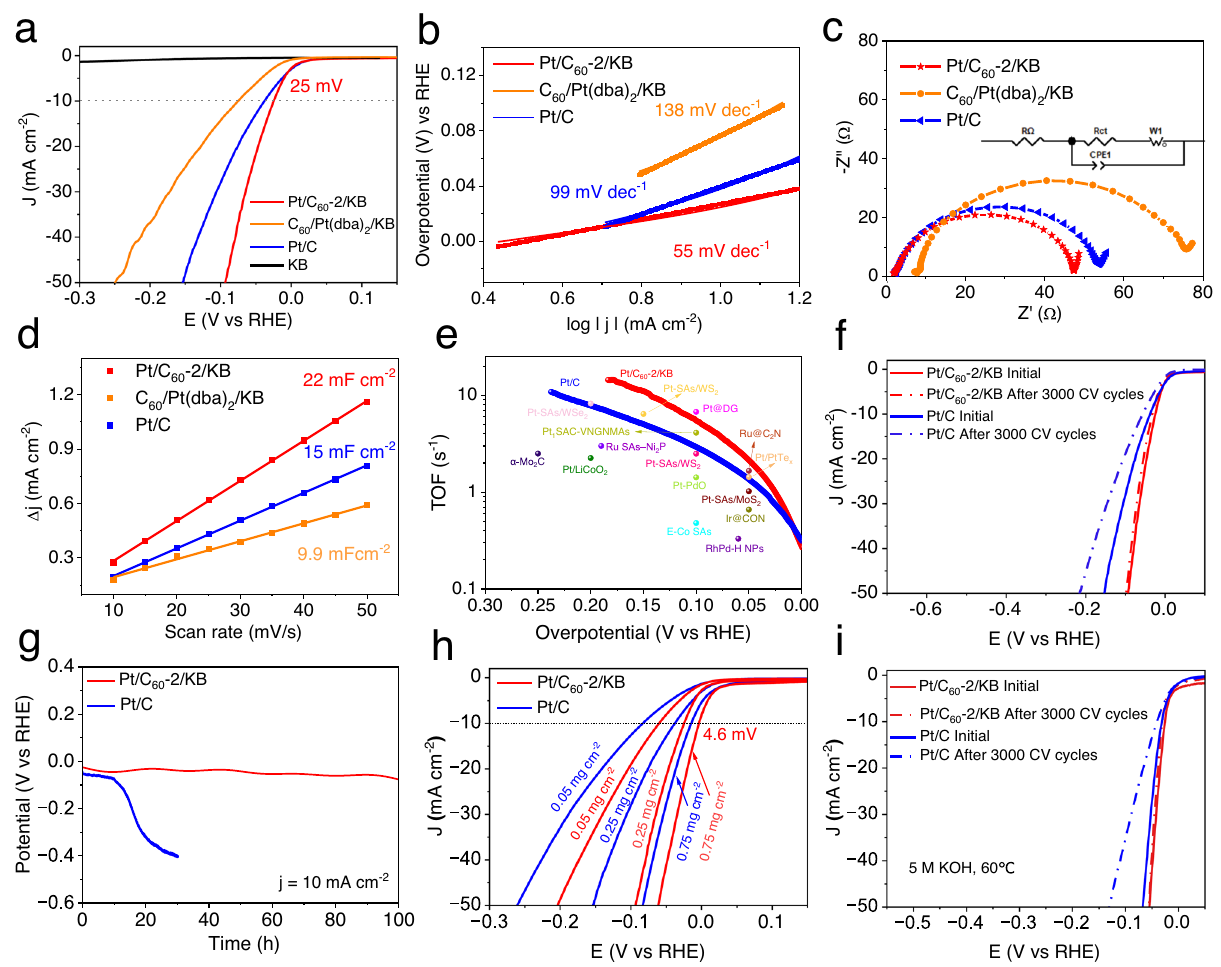
Fig. 5 | HER performance of Pt/C 60 -2 and commercial Pt/C. a HER polarization curves for Pt/C 60 -2/KB, C 60 /Pt(dba) 2 /KB, Pt/C, and KB in 1M KOH. b Tafel plots derived from the corresponding polarization curves. c Nyquist plots for Pt/C 60 -2/ KB, C 60 /Pt(dba) 2 /KB, and Pt/C at an overpotential of 1.5V (vs RHE) (The system resistanceis2.5 Ω and2.6 Ω forPt/C 60 -2/KBand Pt/Cmeasurements,respectively). d Capacitive Δ j=j a − j c as a function of scan rate in 1M KOH. e TOF values for Pt/ C 60 -2/KB, Pt/C and other reported electrocatalysts over a wide range of